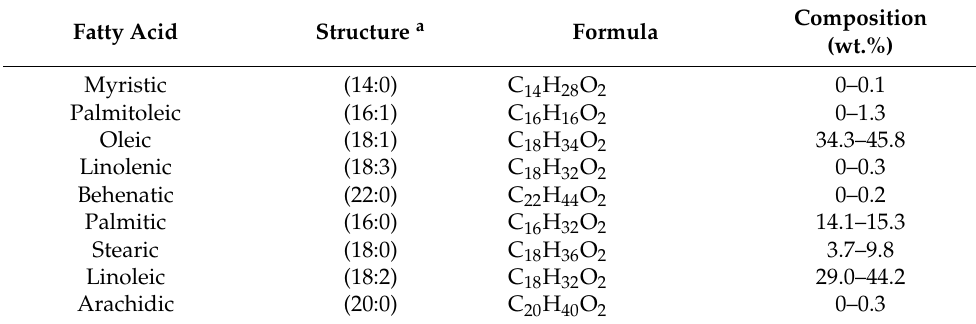
Table 5. Fatty acid’s formation of J. Curcas oil [114,120,127,129].